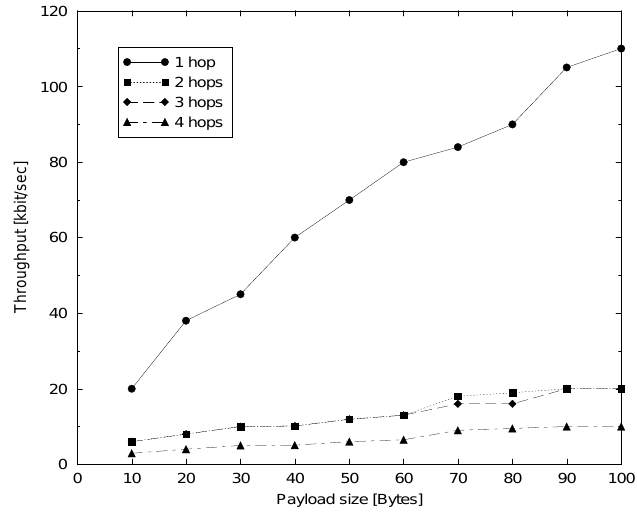
Figure 11. Throughput measured for a point-to-point 802.15.4 network when one, two three or four routers are